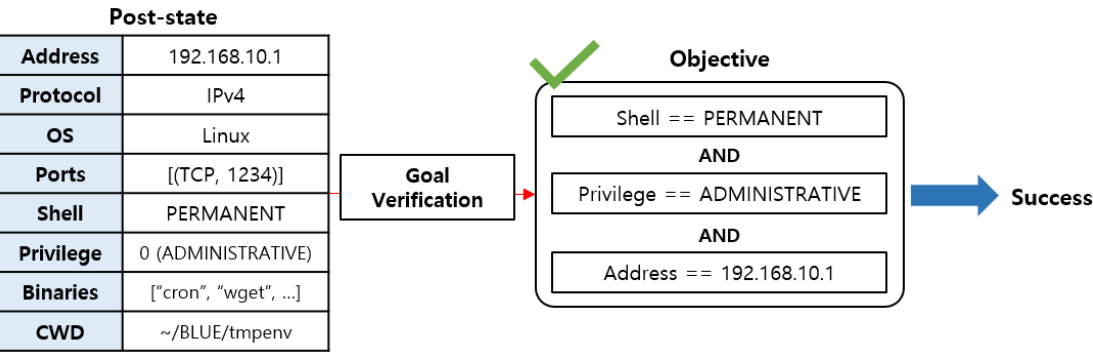
Figure 13. The example of the process of scenario performance: completion of performing a